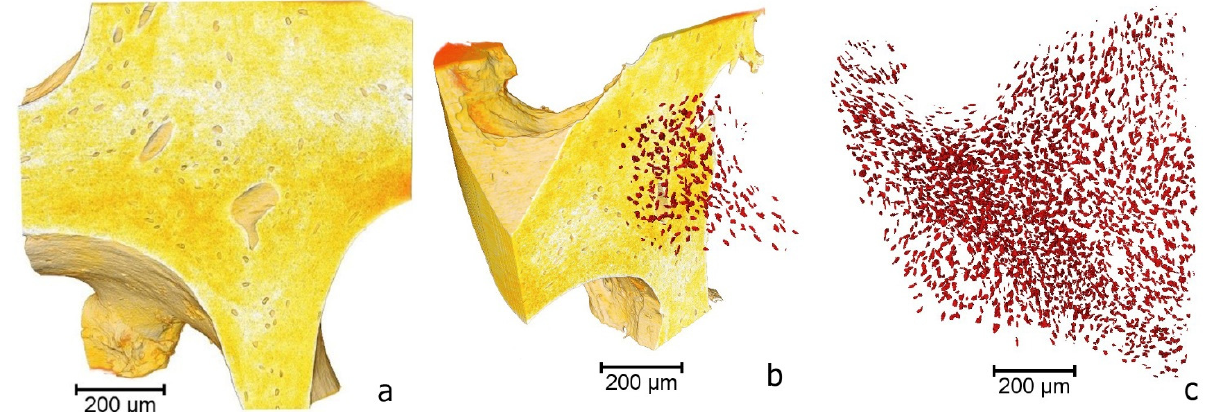
Figure 4. Architectonics of demineralized lyophilized human spongiosa (Micro-CT). Trabecular architecture: (80 kV, 8.6 µm/pixel; 1081 projections; 0.5 s exposition time) ( a )—visualization of the osteocyte lacunae; ( b , c )—image inversion and osteocyte lacunae detection).